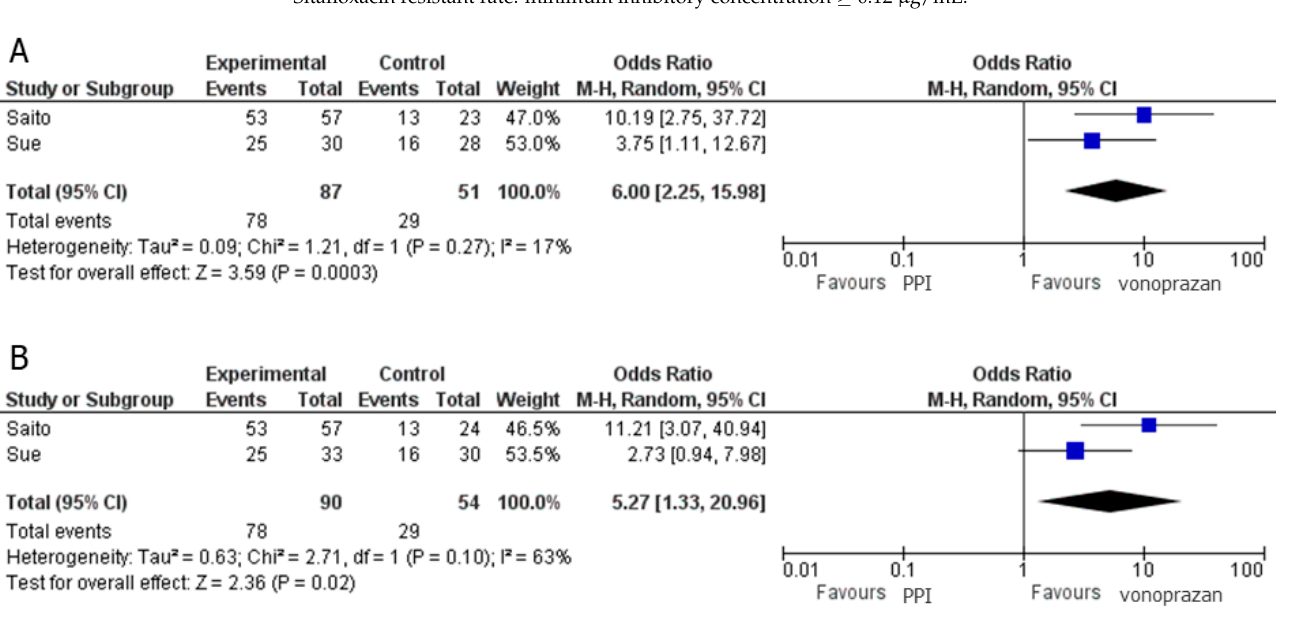
Figure 3. Forest plot of the pooled odds ratio (OR) with 95% confidence intervals (CI) of successful eradication when using regimens of vonoprazan–sitafloxacin–amoxicillin and PPI–sitafloxacin–amoxicillin. ( A ) Per-protocol analysis. ( B ) Intention-to-treat analysis.